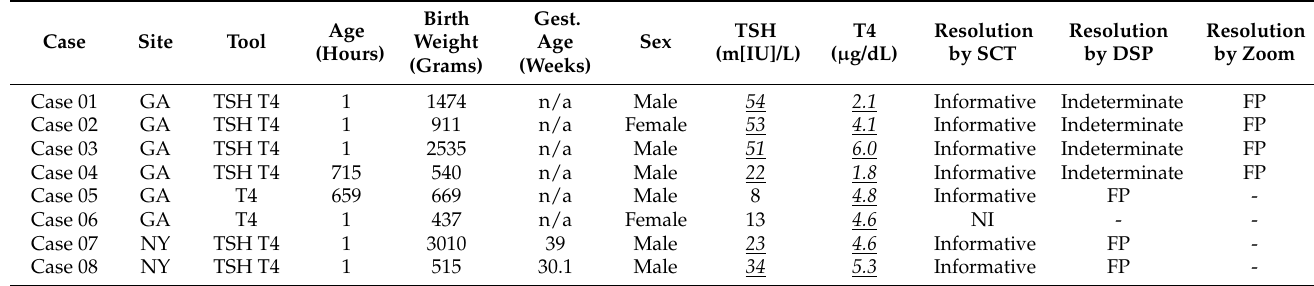
Table 6. True positive screening results resolved as false positive by CLIR